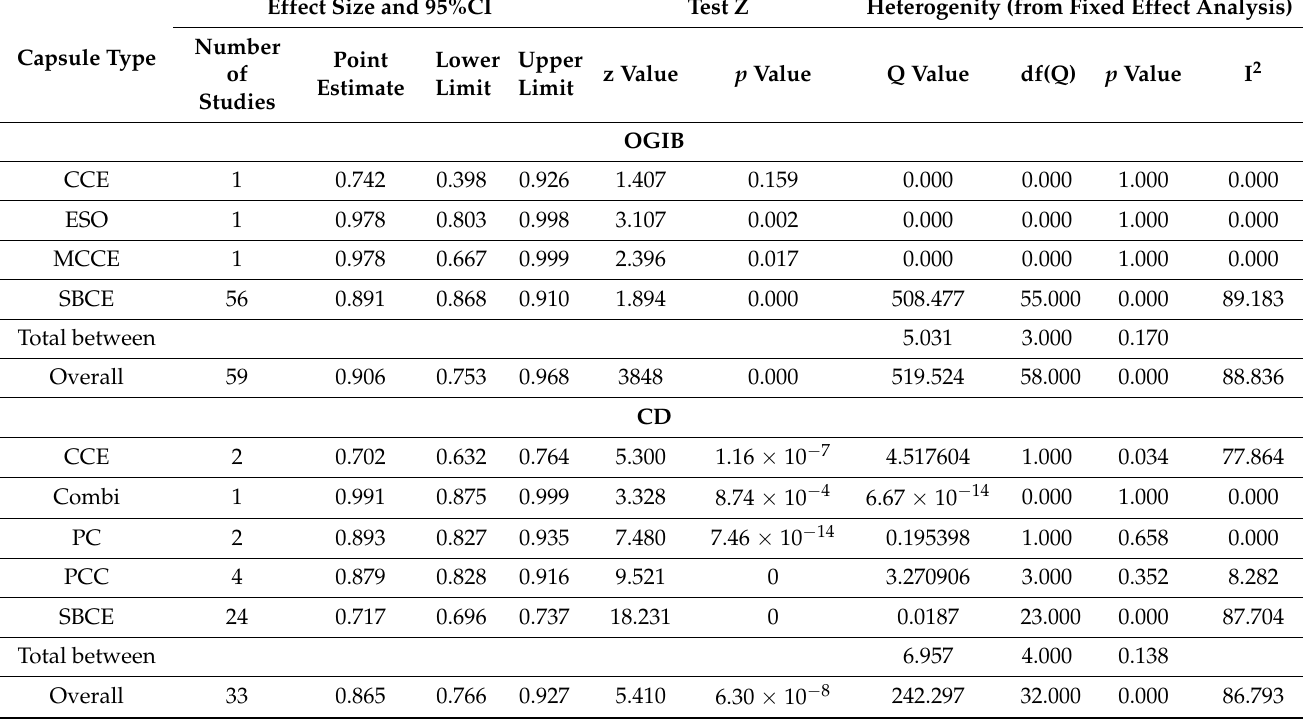
Table 2. Completion rates by type of capsule